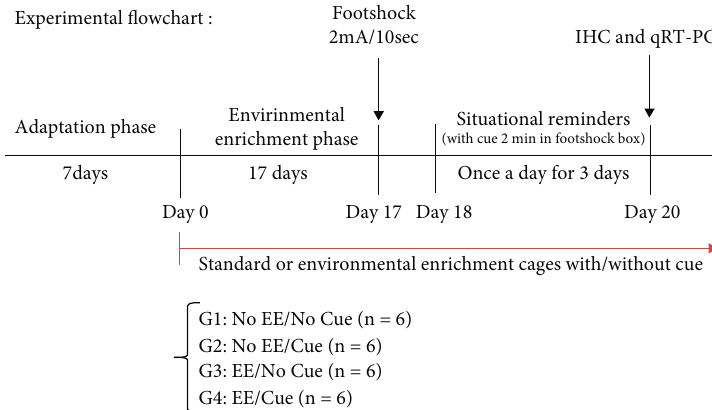
Figure 1: Overview of the experimental procedures. The behavioral processes were shown in the adaptation, EE phase, footshock treatment, and situational reminder phases. On days 0-17, the mice in the EE groups were subjected to the EE procedure. These mice received the EE procedure at the end of the experiment. However, the mice in the no EE groups were housed in the standard cage. On day 17, all mice were placed in the footshock box for 2min, and then the mice were subjected to the footshock treatment (2 mA, 10 seconds). On days 18-20, all mice have given a situational reminder procedure that the mice were placed in the footshock box for 2min with the cue ball but not any footshock. One hundred twenty minutes after the last behavioral test, the immunohistochemical staining with the c-Fos protein expression on day 20. All mice were assigned to the no EE/no cue, no EE/cue, EE/no cue, and EE/cue groups ( n = 6 , per group). EE: environmental